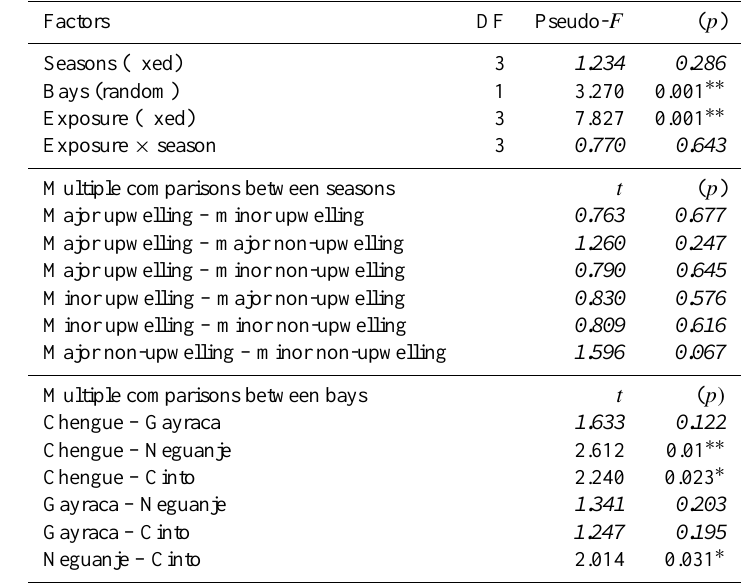
Table 4. Multivariate analyses: significant differences among environmental sedimentary parameters in Tayrona National Natural Park and multiple comparisons between seasons and bays. Main effects of multivariate analyses and the multiple comparisons between seasons (major upwelling, minor upwelling, major non-upwelling, and minor non-upwelling) and bays (Chengue, Gayraca, Neguanje, and Cinto) are shown for the parameters sedimentary chl a , POC, PON, SOD, and CaCO 3 . Significant PERMANOVA results are indicated by asterisks with ∗ for significant ( p < 0.05) and ∗∗ for very significant ( p < 0.01). Not significant values are displayed in italics. Abbreviations as previously defined in Table 1 and sediment oxygen demand